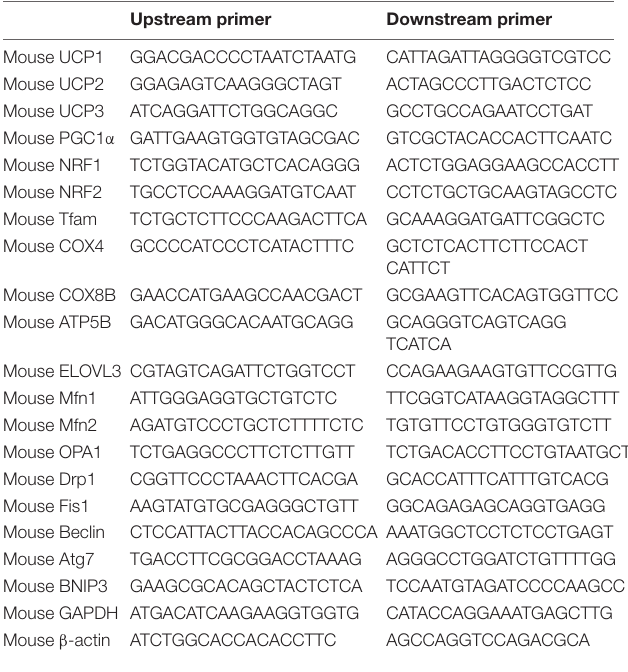
TABLE 1 | Required primer